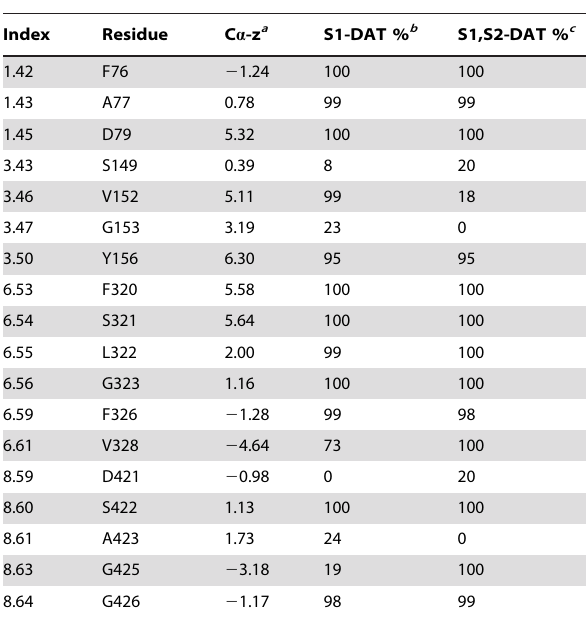
sites. The presence of substrate in the S2 site is associated with a downward repositioning of the center of mass of the S1-bound substrate by 1 A˚ (Figure 2A,B). This is accompanied by the dissociation of several DA-protein contacts, and the formation of new ones (Figure 2B). Comparison of the equilibrated S1-DAT and S1,S2-DAT models showed that the downward repositioning is enabled by the rearrangement of (i)-several conserved hydrophobic residues within the S1 site, or in between the S1 and S2 sites (e.g., the significant changes of F76 1.42 , Y156 3.50 and F320 6.53 shown in Figure 2B), and (ii)-the interposed water molecules. The rearrangement involved in the S1/S2 allosteric interaction is accomplished by a set of highly conserved residues that are not sequential in the primary structure, but form a network in space as indicated in Figure 2. Compared to S1-DAT, which corresponds to the LeuT crystal structure, in the S1,S2-DAT model the EL2 and EL4 loops have moved towards the S2 substrate and pushed the extracellular segment of TM3 inward to the S2 site (see Figure S1 in File S1). This appears to cause conformational changes in the S1 site, propagated through a conserved interaction network (Table S1 in File S1). The dynamic sequence of events has I390 EL4 and F391 EL4 pushing the sidechain of W84 1.50 , and then of L80 1.46 down toward the S1 site (Figure 2C). As a result, the sidechains of Y156 3.50 and F320 6.53 that are located between the S1 and S2 sites and have their phenyl rings above the catechol moiety of DA, rotated to push downward on the ligand in the S1 site. F155 3.49 facilitated the rotation of Y156 3.50 in a rearrangement that is likely due to its interaction with the substrate in the S2 site. Thus, the communication between the S1 and S2 sites appears to depend on this sequence of rearrangements of the highly conserved set of hydrophobic and aromatic residues (L80 1.46 ,